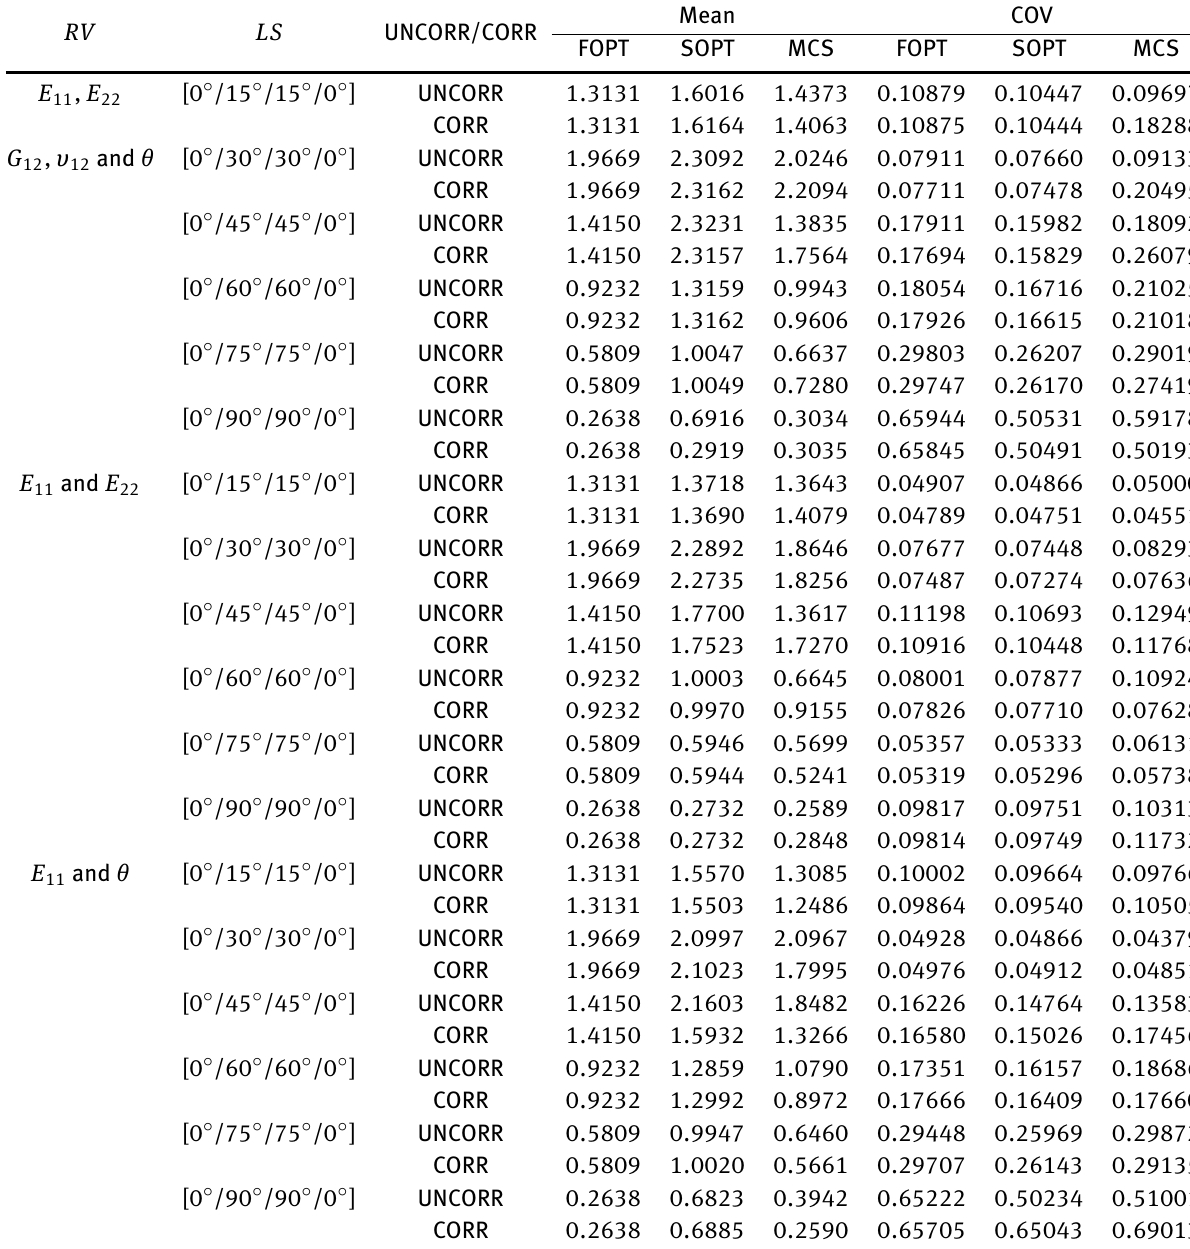
Table 8: Effect of combined uncorrelated (UNCORR) and combined correlated (CORR) random variables on the normalized mean and COV of SIF K II with COC=0.1 and COR=0.5 for different lamination schemes ( LS )